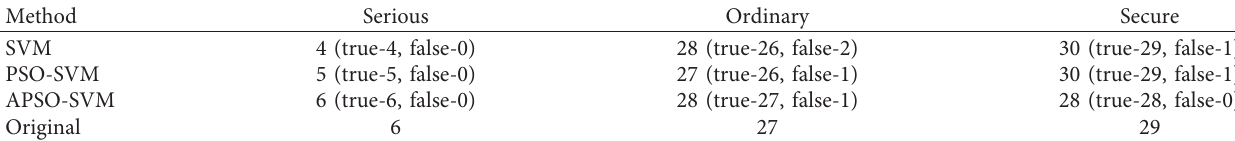
Table 3: Detailed prediction results of the three models.